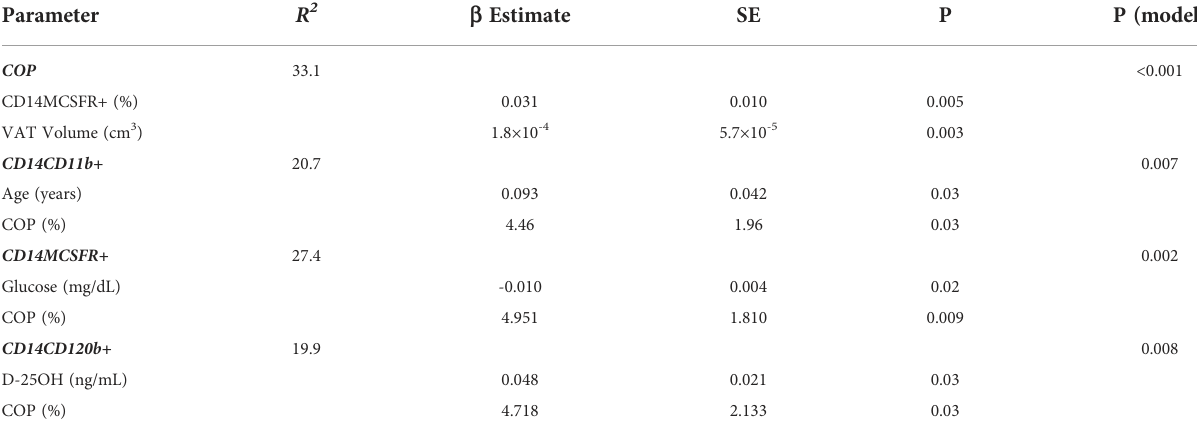
TABLE 5 Multivariate regression analysis of circulating osteogenic progenitors and osteoclast precursors with variables of interest. Parameter R